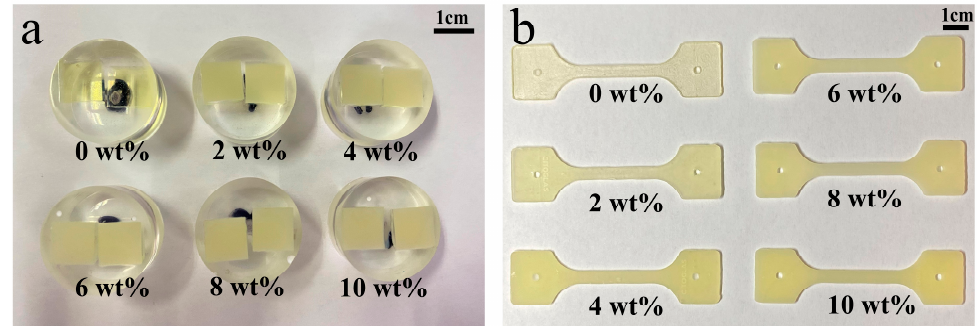
Figure 1. Photography of the samples adopted for ( a ) the nanoindentation tests and ( b ) the macroscale tensile tests.